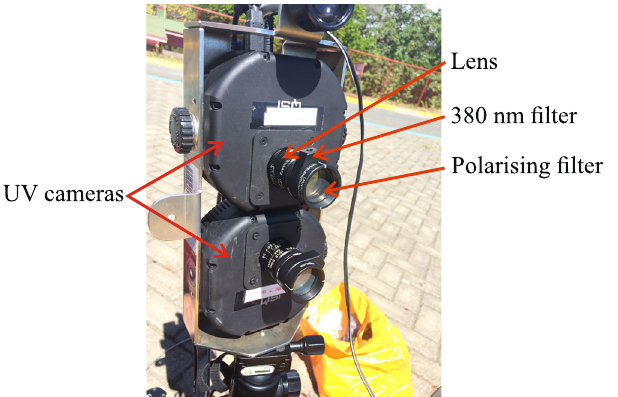
Figure 6. Setup of AshCam. The cameras are fitted with a 380 nm band filter (FWHM = 10 nm) and a polarising filter mounted to the front of each lens. The cameras are mounted on a standard tripod and powered using a pair of Lithium Polymer